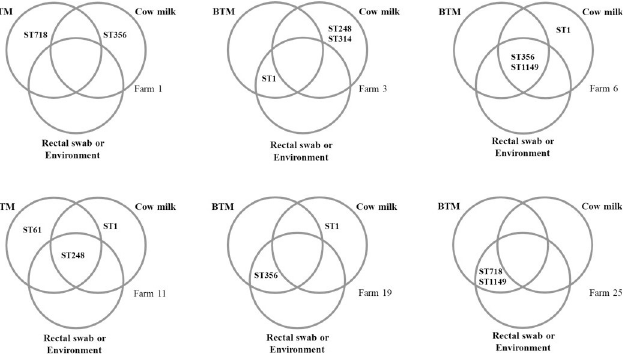
Fig 1. Examples of the distribution of Streptococcus agalactiae sequence types (ST) across sample types on Colombian dairy farms. BTM = bulk tank milk. Details of the number of isolates per ST and sample type are given in Table A in S1 Supporting